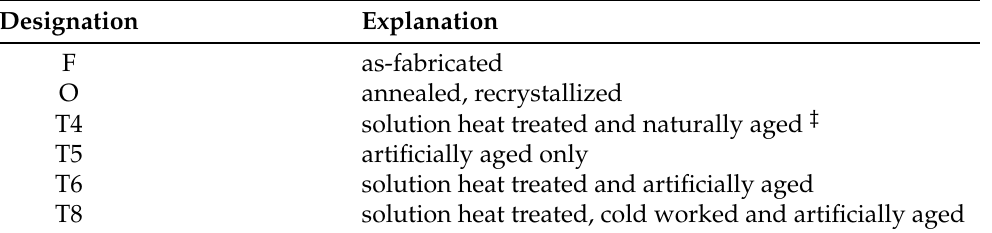
Table A2. Temper designations used in this work.